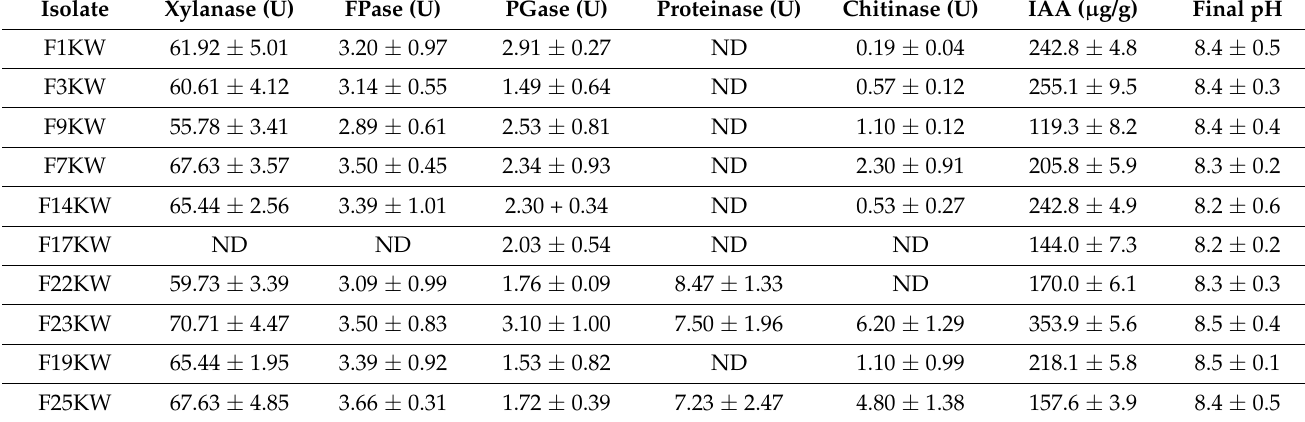
Table 1. Enzymatic profile, indole acetic acid biosynthesis, and final pH of the endophytic bacterial isolates.